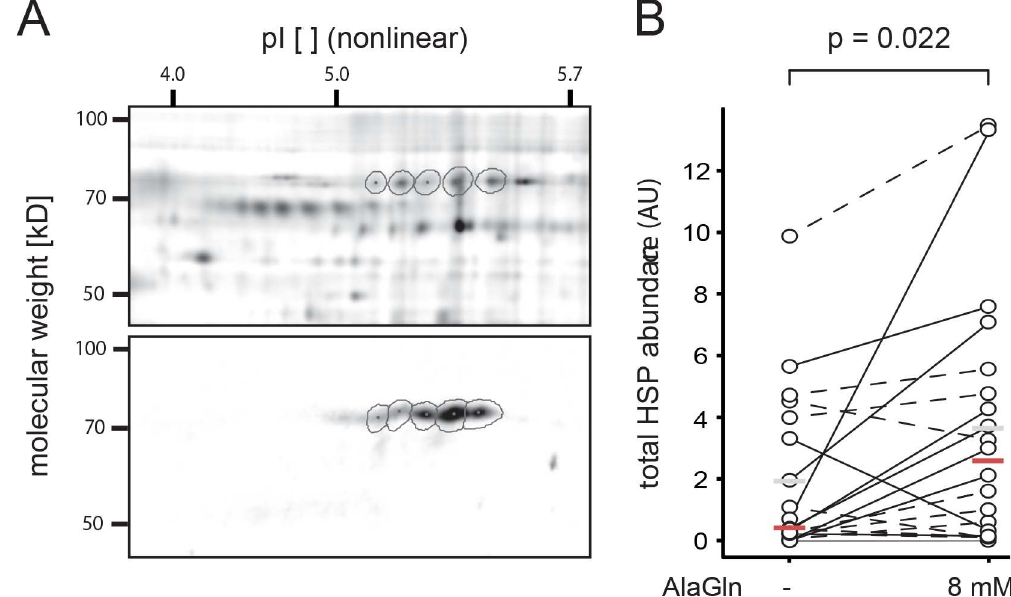
Fig 3. AlaGln treatment increased HSP expression in peritoneal effluent cells. Peritonealcellular HSP expressionin the study samples was detected by combiningsaturation labelingtwo-dimensional difference gel electrophoresis (2D-DIGE) with 2-D Western blotting. In panel A the upper segment shows the fluorescently labeledprotein pattern whereas the lower segment shows the signals from immune-blotting, superimposed by the gel warping capabilities of Delta 2D software. The first dimension separationaccording to the isoelectric point (pI) was carried out on a nonlineargradient. Panel B shows the quantificationof total abundanceof Hsp72 spot volumes, normalized by the internal standard. Total abundanceof Hsp72 increasedfrom 2.12 (CI 1.46–3.09) without AlaGln to 3.20 (CI 2.20–4.66)with AlaGln (effect size 1.51 (CI 1.07–2.14), p = 0.022) (N = 20 in each group, Counts: up = 14; down = 6). Grey bars indicate the mean; red bars indicate the median in each group.